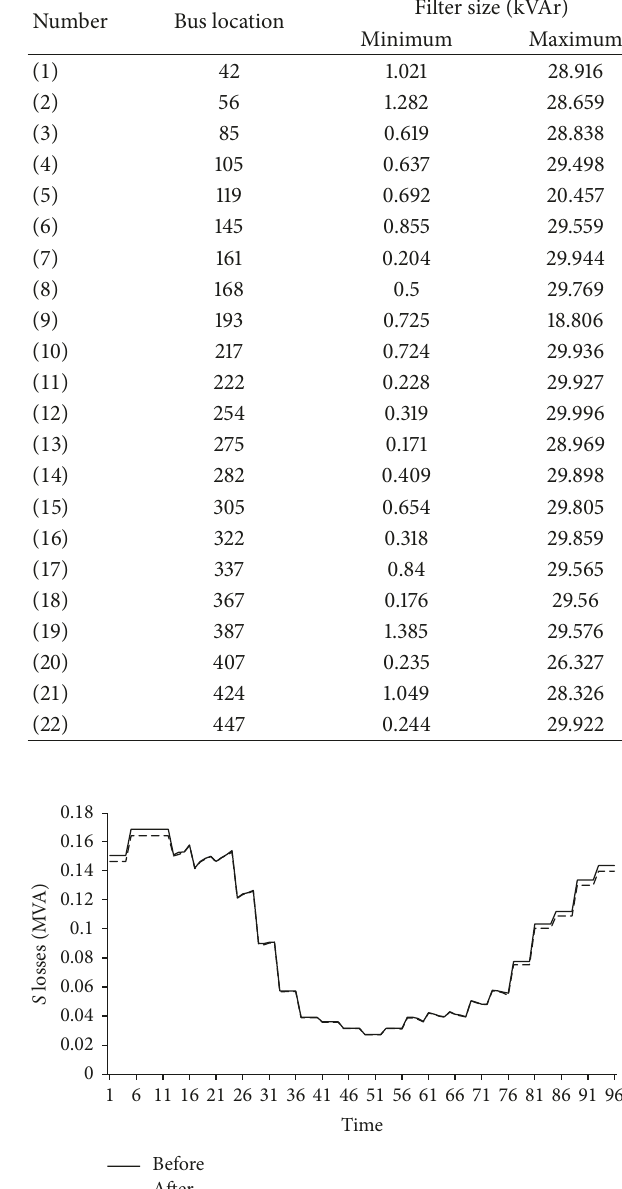
Table 9: Minimum and maximum VPF size based on 96 simula- tions.